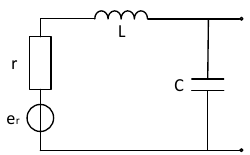
Figure 7. Noise distribution map with matching resistance sensor.